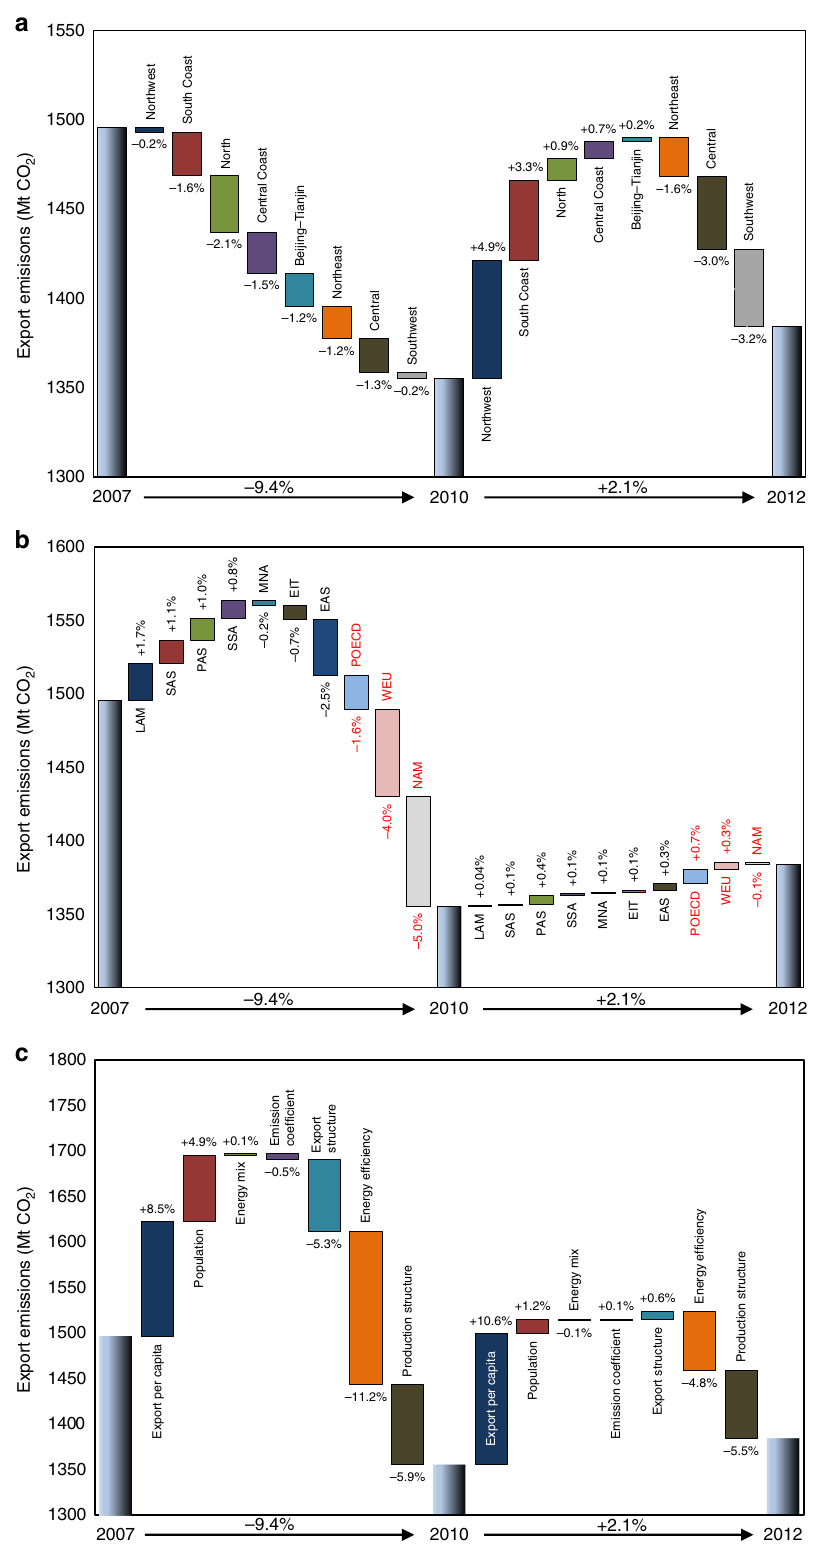
Fig. 4 Changes in emissions embodied in exports between 2007 and 2012. a Changes in the export emissions from eight Chinese regions. b Changes in China ’ s export emissions to 10 global regions. Regions in red are developed countries, while regions in black are developing countries. LAM: Latin America and the Caribbean; SAS: South Asia (mainly India); PAS: South-East Asia and the Paci fi c; SSA: Sub-Saharan Africa; MNA: the Middle East and North Africa; EIT: Economies in Transition (including Eastern Europe and the Former Soviet Union); POECD: Paci fi c OECD-1990 Countries (including Japan, Australia, and New Zealand); EAS: East Asia (China excluded); WEU: Western Europe; NAM: North America (USA and Canada). See Supplementary Data 1 for de fi nitions of world regions. c Contributions of different factors to changes in China ’ s export emissions. Mt CO 2 means million tonnes of carbon